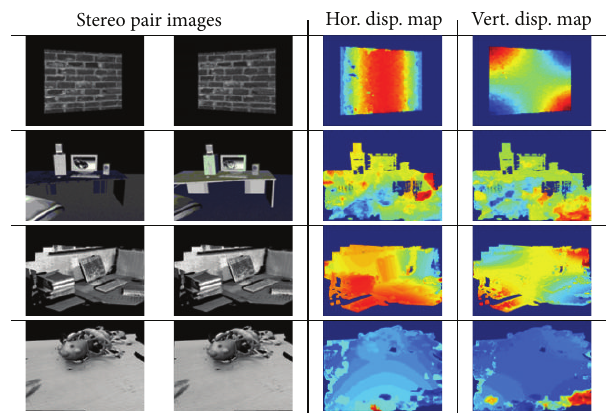
Figure 7: Disparity estimation results obtained on some vergent stereo image pairs generated by a simulator developed in [89] by applying the PBBDE approach. The disparity maps are coded from red (positive values of disparity) to blue (negative values).